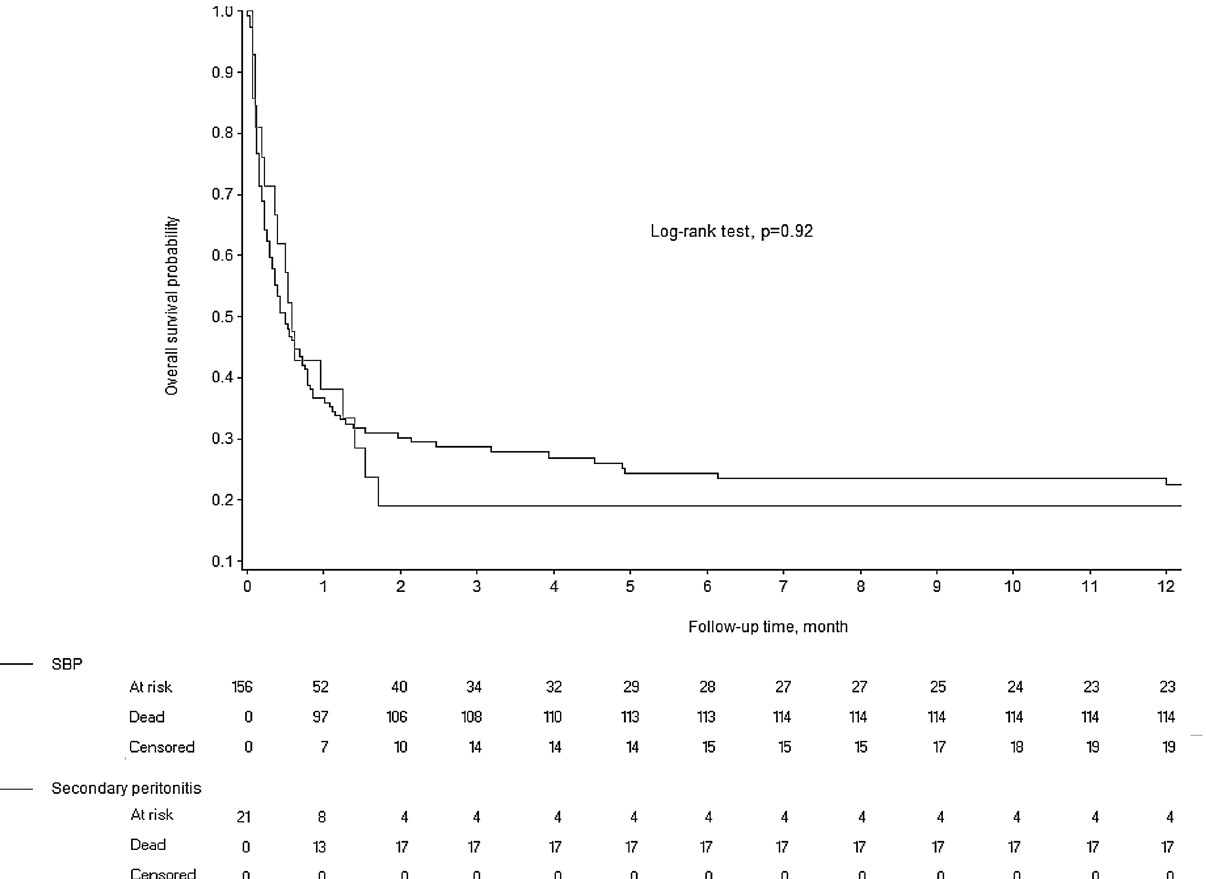
Figure 1. Kaplan–Meier estimates of overall survival in patients with spontaneous bacterial/fungal peritonitis (SBFP) and secondary peritonitis